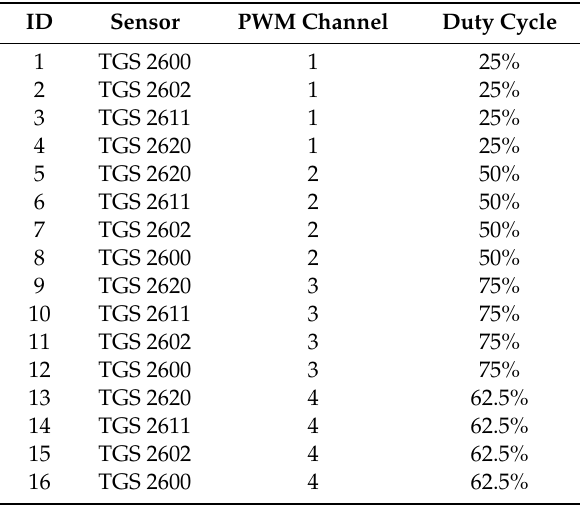
Table 1. Metal-oxide (MOX) sensors used in the electronic board and duty cycle applied. ID—identifier; PWM—pulse width